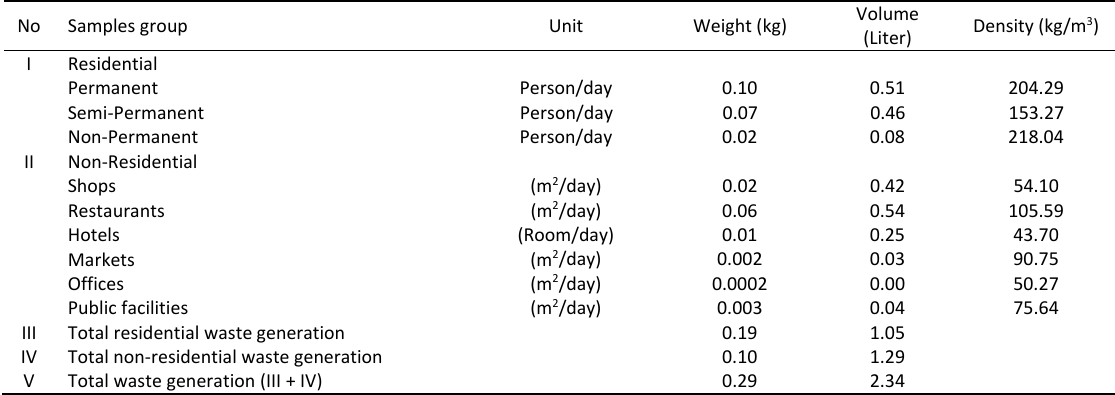
Table 2: Weight, volume, and waste density in SZGR